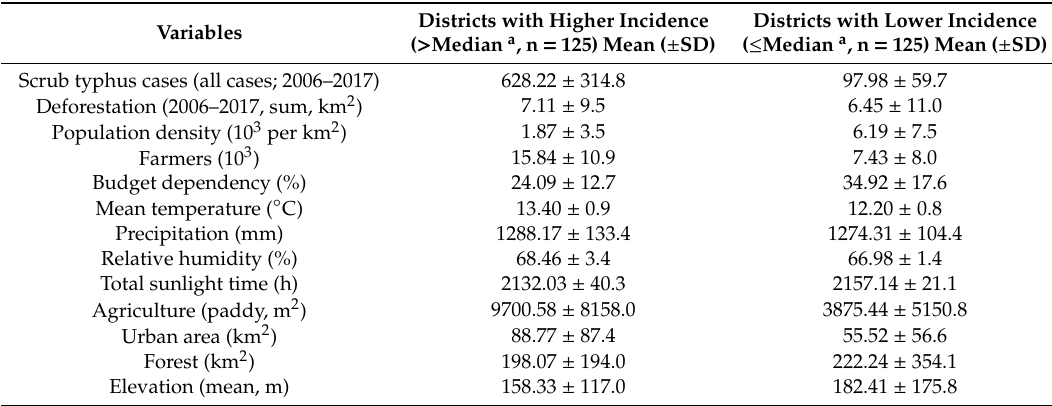
Table 2. Descriptive analysis of the variables used in the models by the incidence of scrub typhus.